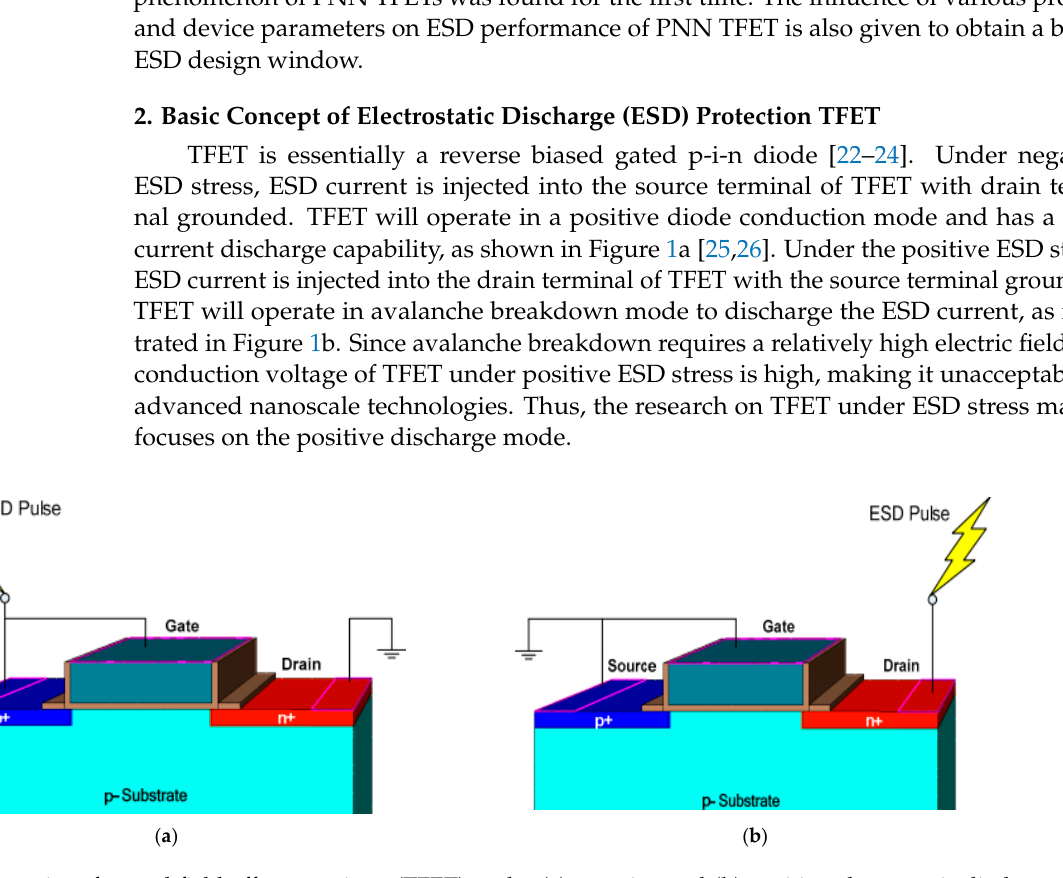
Figure 1. Schematics of tunnel field-effect transistor (TFET) under ( a ) negative and ( b ) positive electrostatic discharge (ESD) stresses.